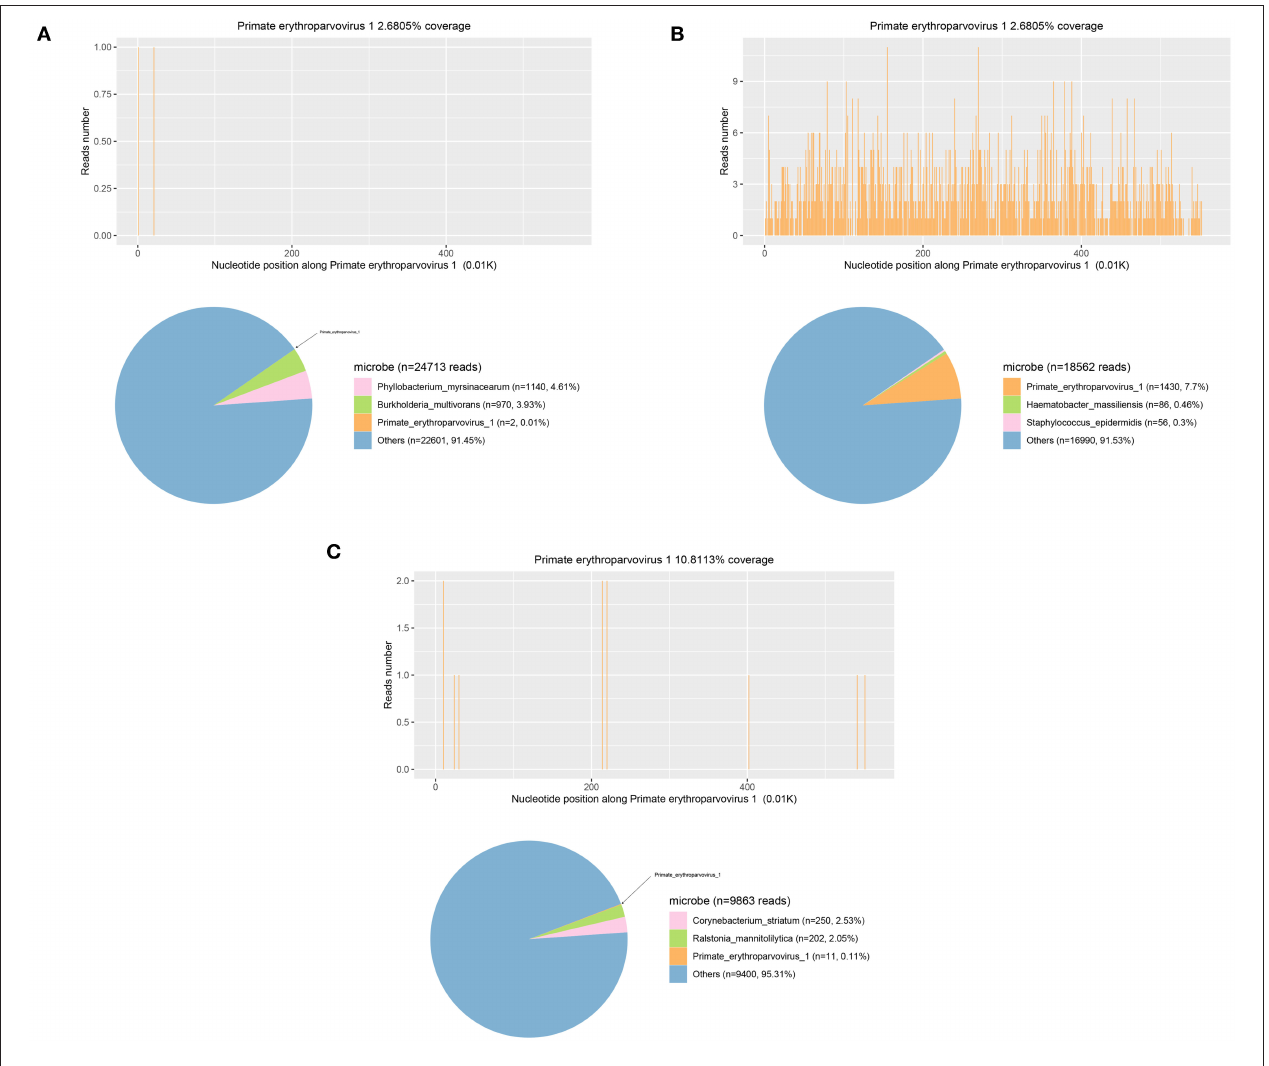
FIGURE 2 | mNGS detection of CSF (A) , blood (B) , and bronchoalveolar lavage fluid samples (C)